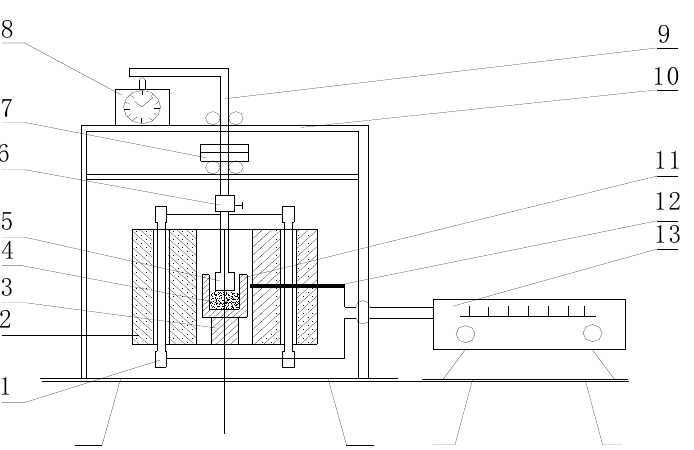
Figure 3. Schematic diagram of the experimental apparatus: 1, Si-C heater; 2, shell; 3, Al 2 O 3 Pedestal; 4, sample; 5, Si-C bar; 6, fastening screws; 7, load; 8, m 9, steel bar; 10, bracket; 11, graphite crucible; 12, thermocouple; 13, temperature program controller).